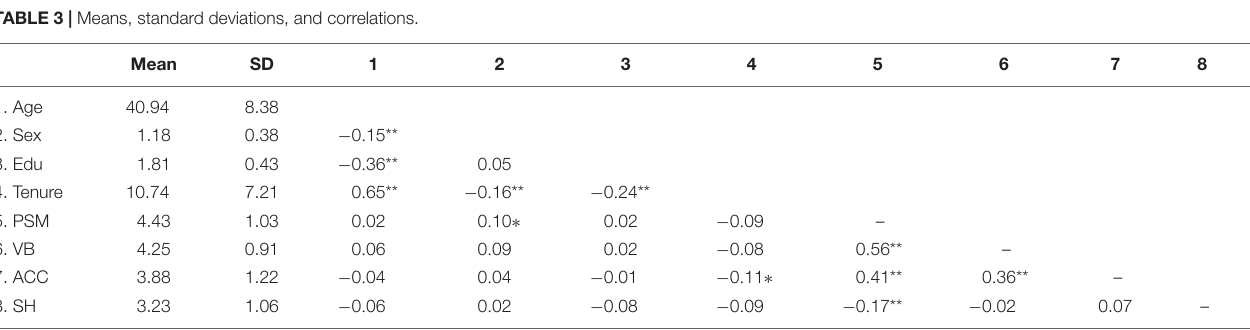
TABLE 3 | Means, standard deviations, and